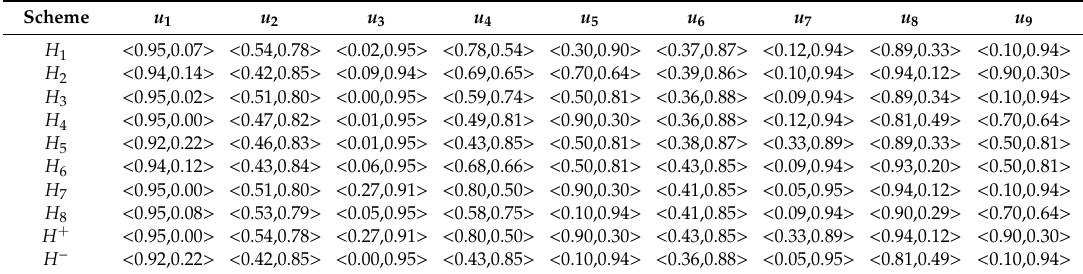
Table 3. Normalized Pythagorean fuzzy decision